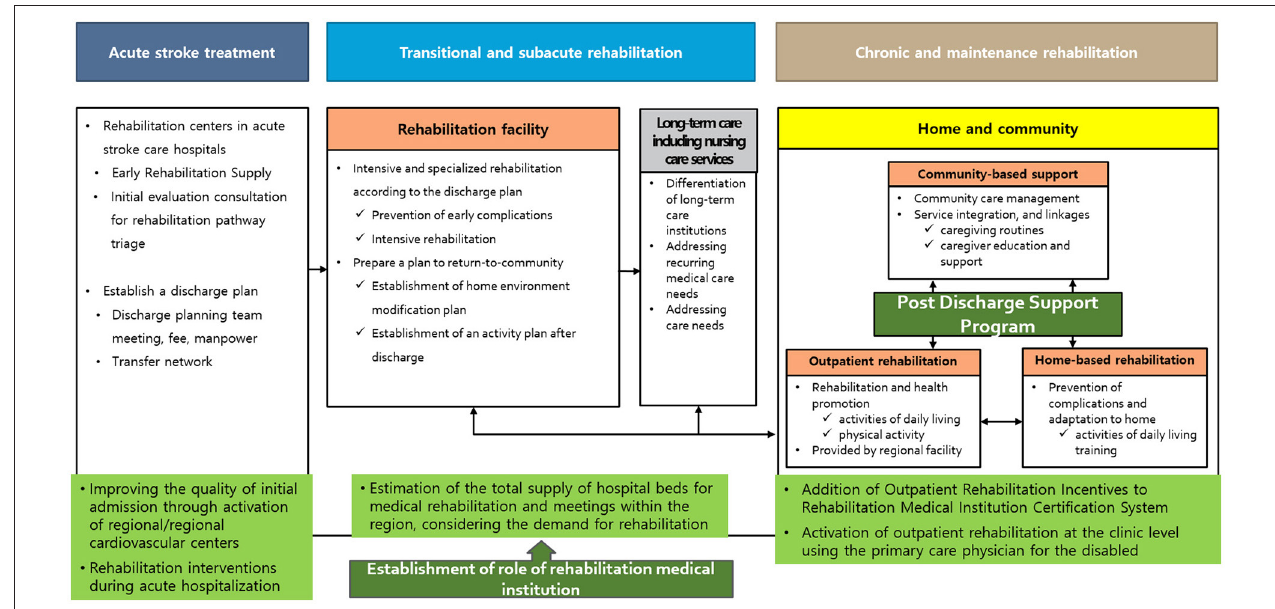
FIGURE 2 | Model of the medical rehabilitation supply system [adopted from